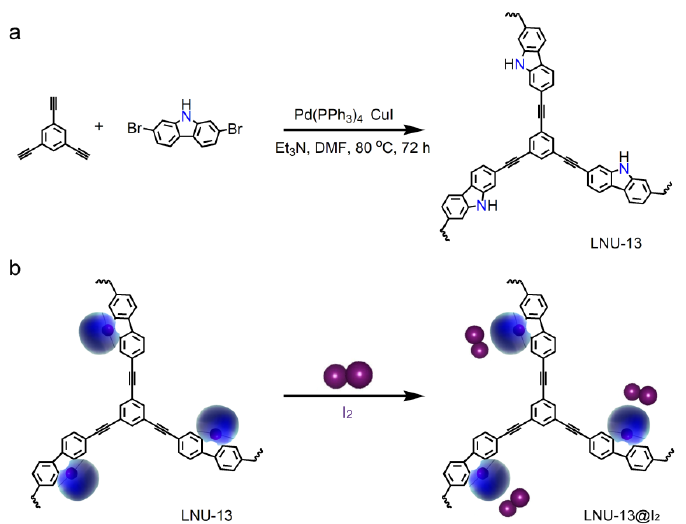
Figure 1. ( a ) Synthesis of LNU-13 polymer; ( b ) schematic diagram of PAF solid for I 2